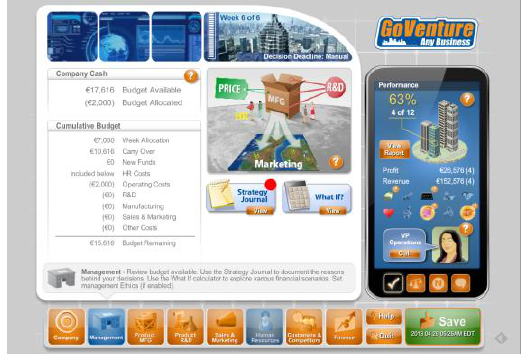
Figure 4: The Any Business ’ main control